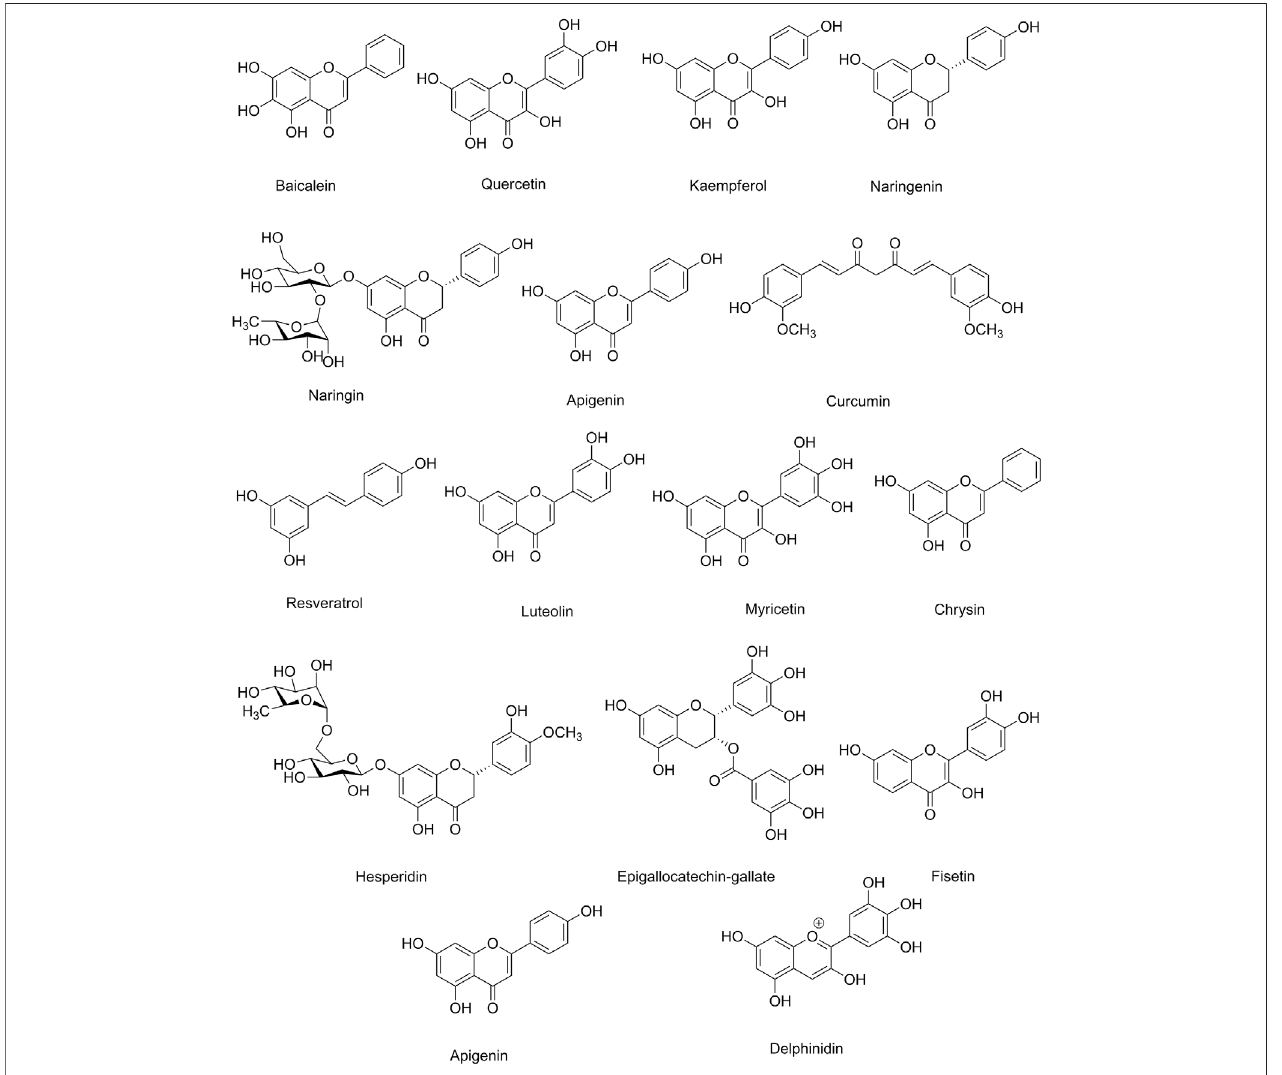
FIGURE 2 | Selected chemical structures of phenolic compounds in combating neuronal signs of emerging infectious diseases.